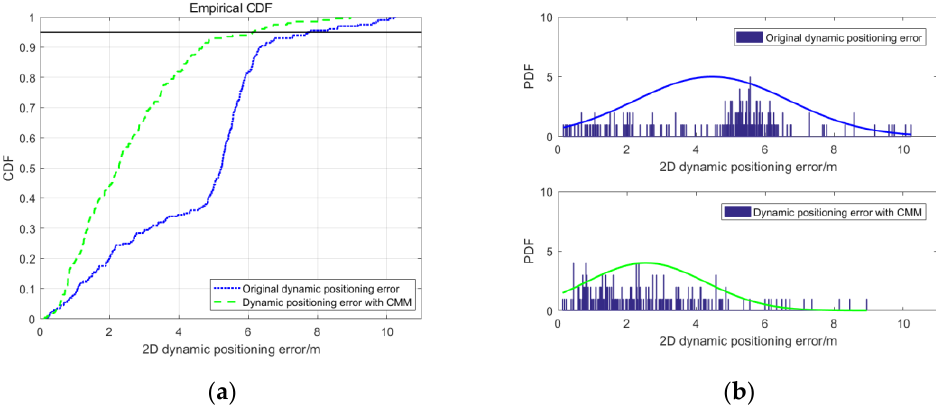
Figure 12. The CDF and PDF of 2D dynamic positioning error. ( a ) CDF; ( b ) PDF.